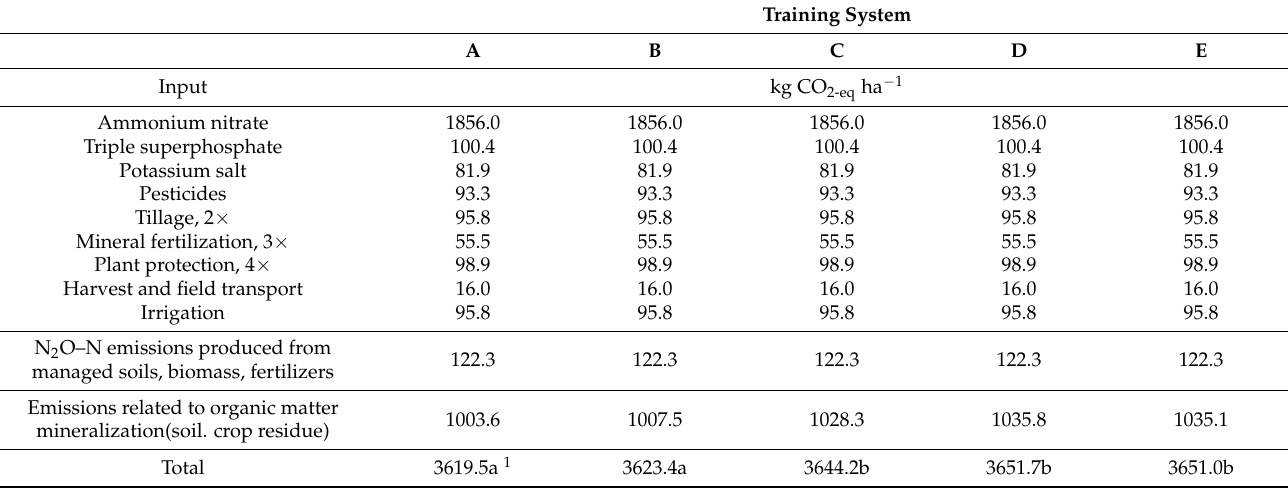
Table 7. Total GHG emissions associated with annual production (kg CO 2-eq ha − 1 ).